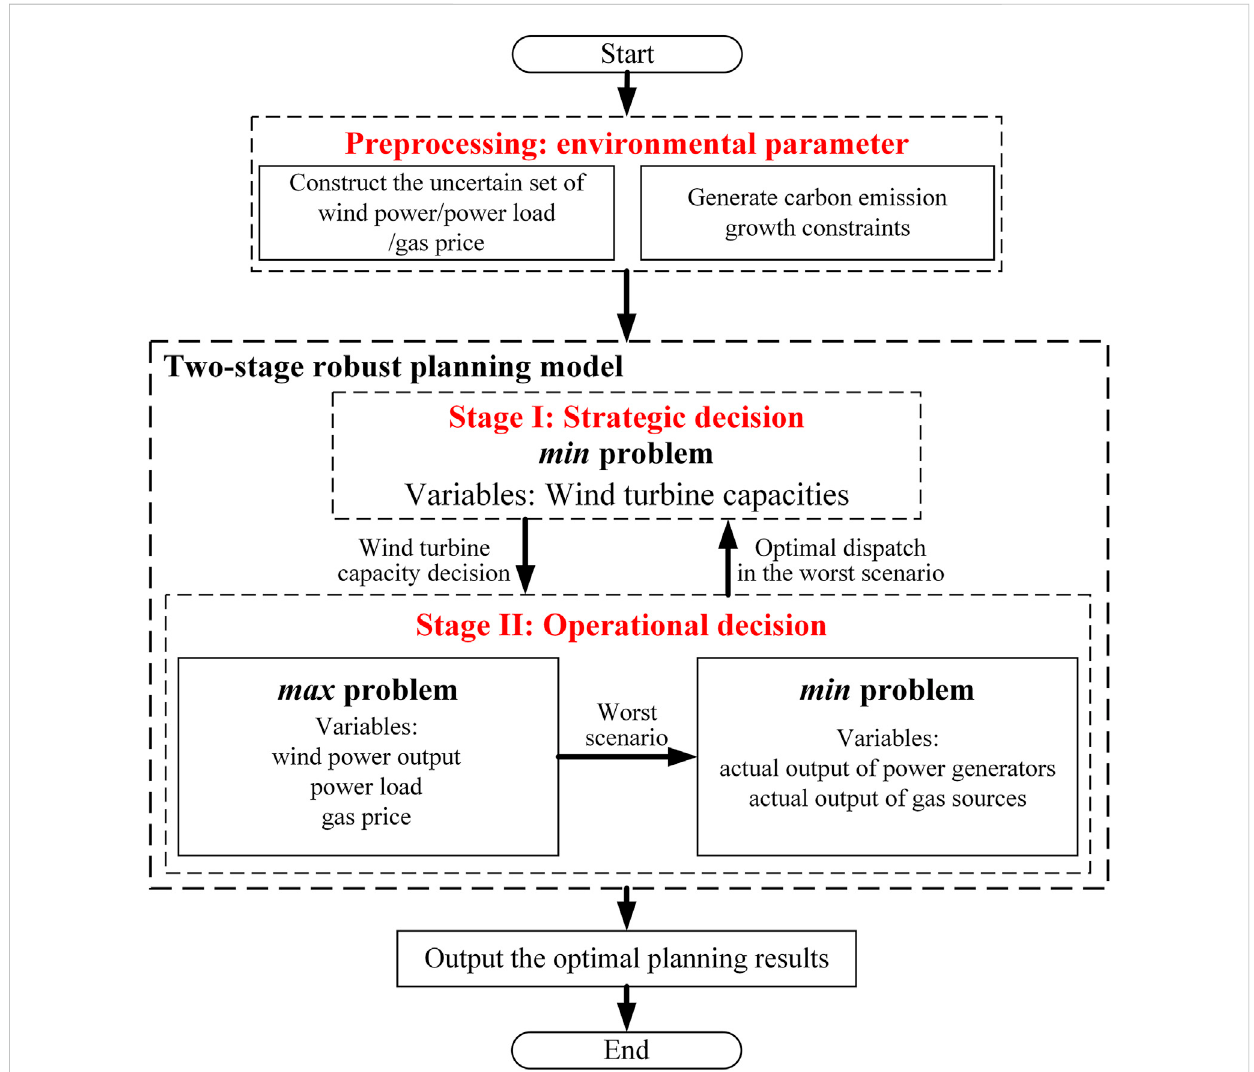
FIGURE 1 The schematic diagram of the proposed two-stage robust generation expansion planning framework.